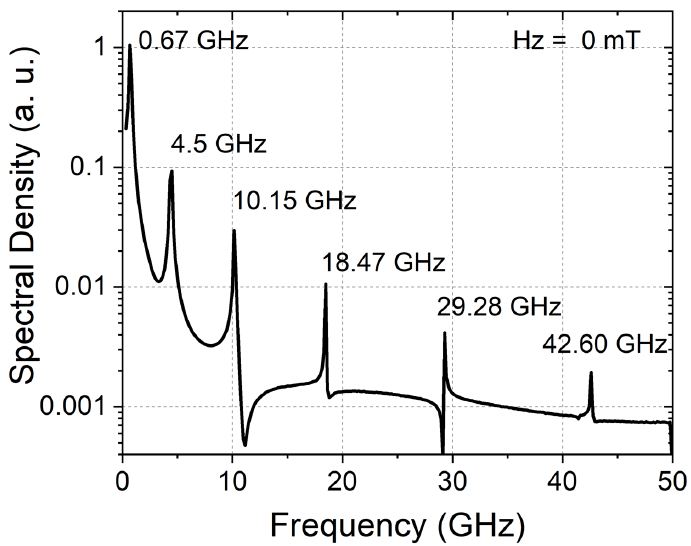
Figure 6. Spectral density in zero static field obtained from Fourier analysis of the dot response calculated by MuMax with the following parameters: dot diameter = 150 nm, dot thickness = 1.4 nm, M = 1220 emu/cm 3 , K = − 1.04 erg/cm 3 , D = − 1.34 erg/cm 2 , A = 1.6 µ